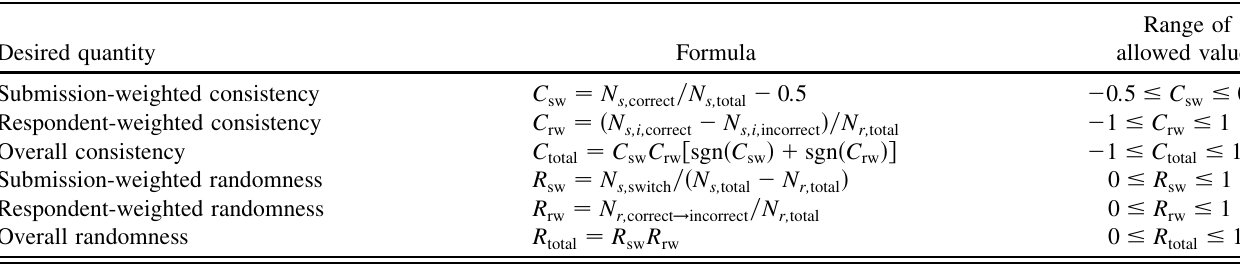
TABLE I. Summary of algorithms for computing class-wide consistency ( C ) and randomness ( R ) in responses to true or false statements. In all cases the subscript s denotes submission and the subscript r denotes respondent. In the formula for C the subscript switch indicates a submission which is the opposite response from indicates the initial submission, in the formula for R sw the subscript correct ! incorrect indicates the number of respondents who ever its immediate predecessor, and in the formula for R rw switched their answer to the statement from correct to